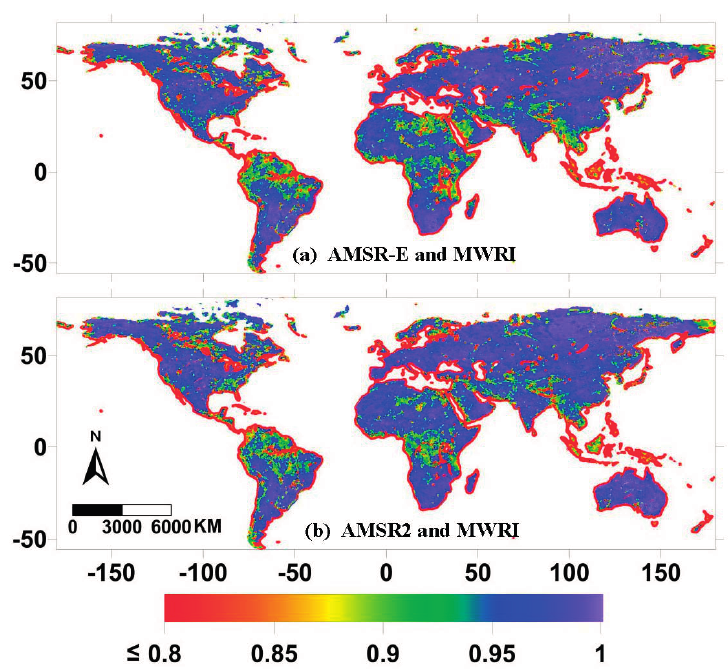
Figure 2. Spatial distribution of the correlation coefficients calculated from four-month overlapping ( a ) AMSR-E and MWRI and ( b ) AMSR2 and MWRI datasets for selected observations; lower correlation areas are associated 23 GHz, H-Polarized ascending orbit T b with coastal boundaries having large dielectric differences between land and open water features, and other heterogeneous land